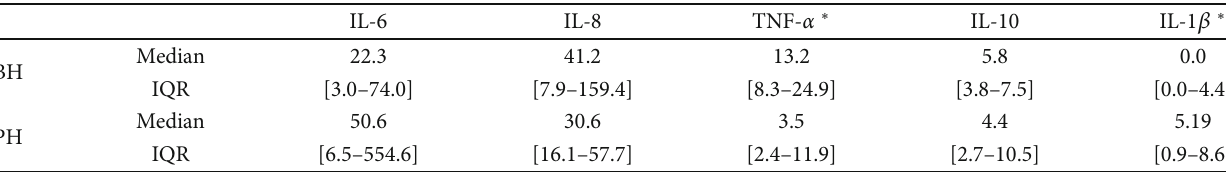
Table 3: Cytokine concentrations.